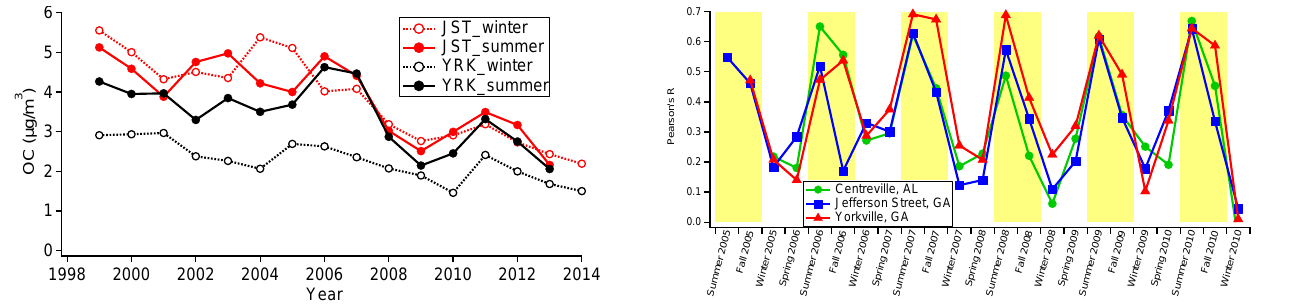
Figure 15. Mean seasonal concentrations of organic carbon at the Jefferson Street (JST) and the Yorkville (YRK) sites. Summer is June – August. Winter is December–February.